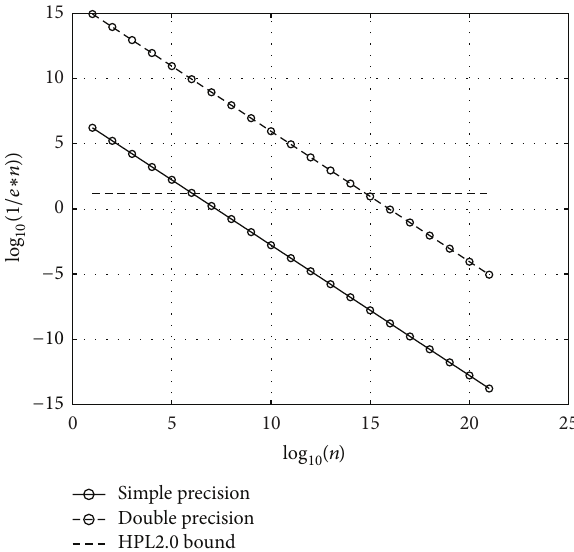
Figure 7: Residual check analysis for solving 𝐴𝑥 = 𝑦 system in HPL2.0 using simple and double precision representation.